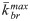
Responses of Fmax and Nmax to treatment with the drugs CK-666 and LatA, and the corresponding phase diagrams.We assume that (A) CK-666 reduces k¯brmax, (B) LatA(1) reduces kon
G only, and (C) LatA(2) reduces both k¯brmax and kon
G. The Nmax−Fmax plots in frames (D)-(F) can be directly compared to experiments. The wild-type data points are denoted by blue open circles, and decreasing k¯brmax and/or kon
G corresponds to moving right in these frames.